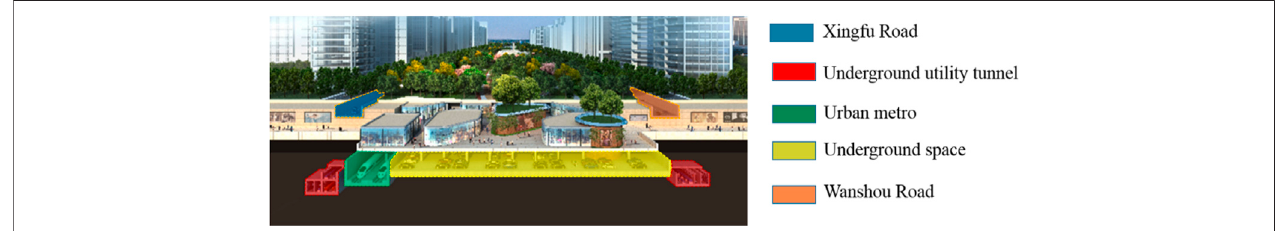
FIGURE 1 | Intersection of integrated Underground utility tunnel and ground fi ssure.